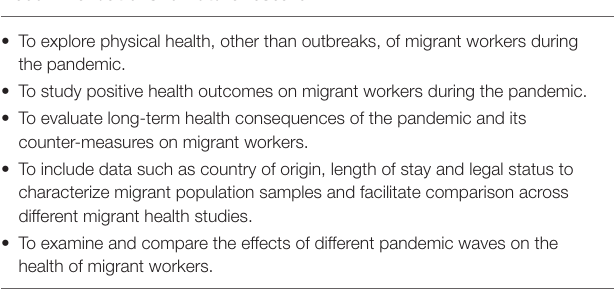
TABLE 4 | Recommendations for future research based on the results of the scoping review. Recommendations for future